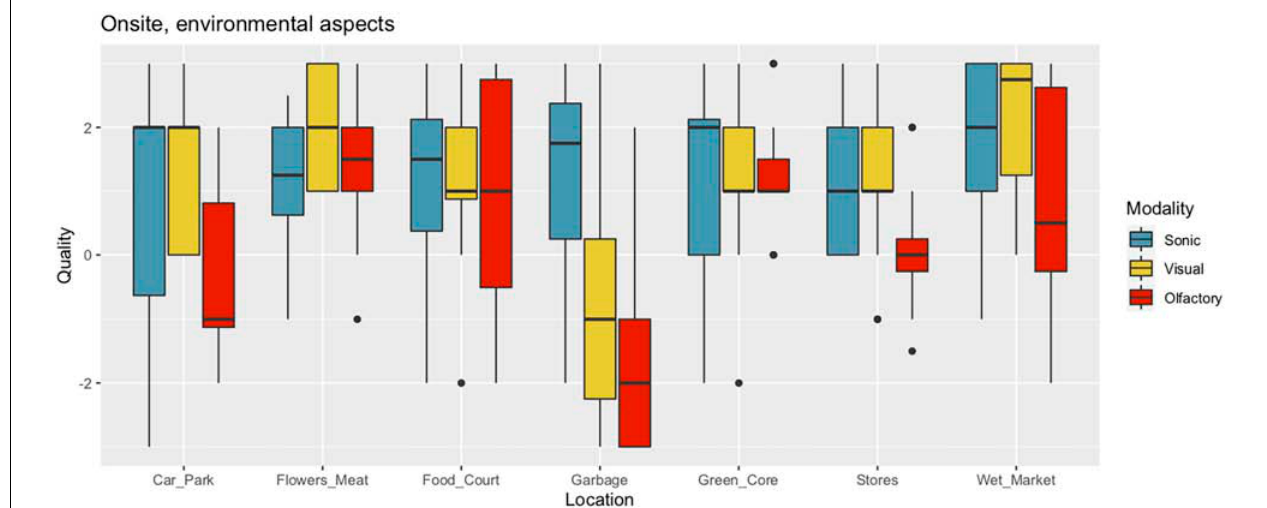
FIGURE 4 | Boxplots of onsite ratings ( N = 15) of three aspects of environmental quality for seven locations. Quality was rated on a seven-step Likert scale; see the text for details.